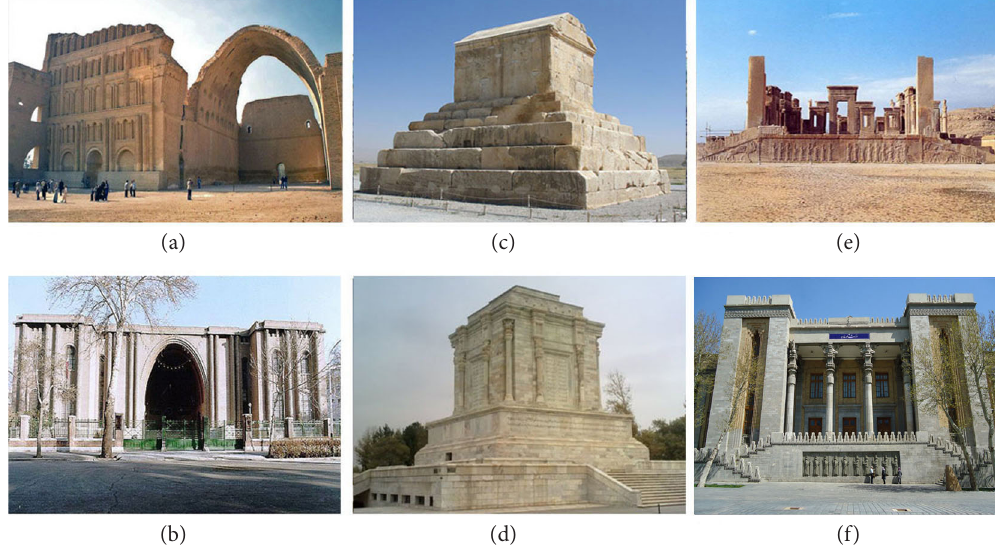
Figure 1. Examples of Iranian ancient architecture and the usage of them in the works of the architects of the first period: (a) Iwan Madaen from 224 CE in Iraq (Asgharzadeh & Mehrnazar, 2009); (b) National Iran Museum in Tehran by Andre Godar, 1934 (Rahimazadeh, 2007); (c) Kourosh Tomb in Psargad from 600 BC (Author, 2011); (d) Ferdosi Tomb in Khorasan by Karim Taherzadeh, 1934 (Author, 2010); (e) Apadana Place in Persepolis from